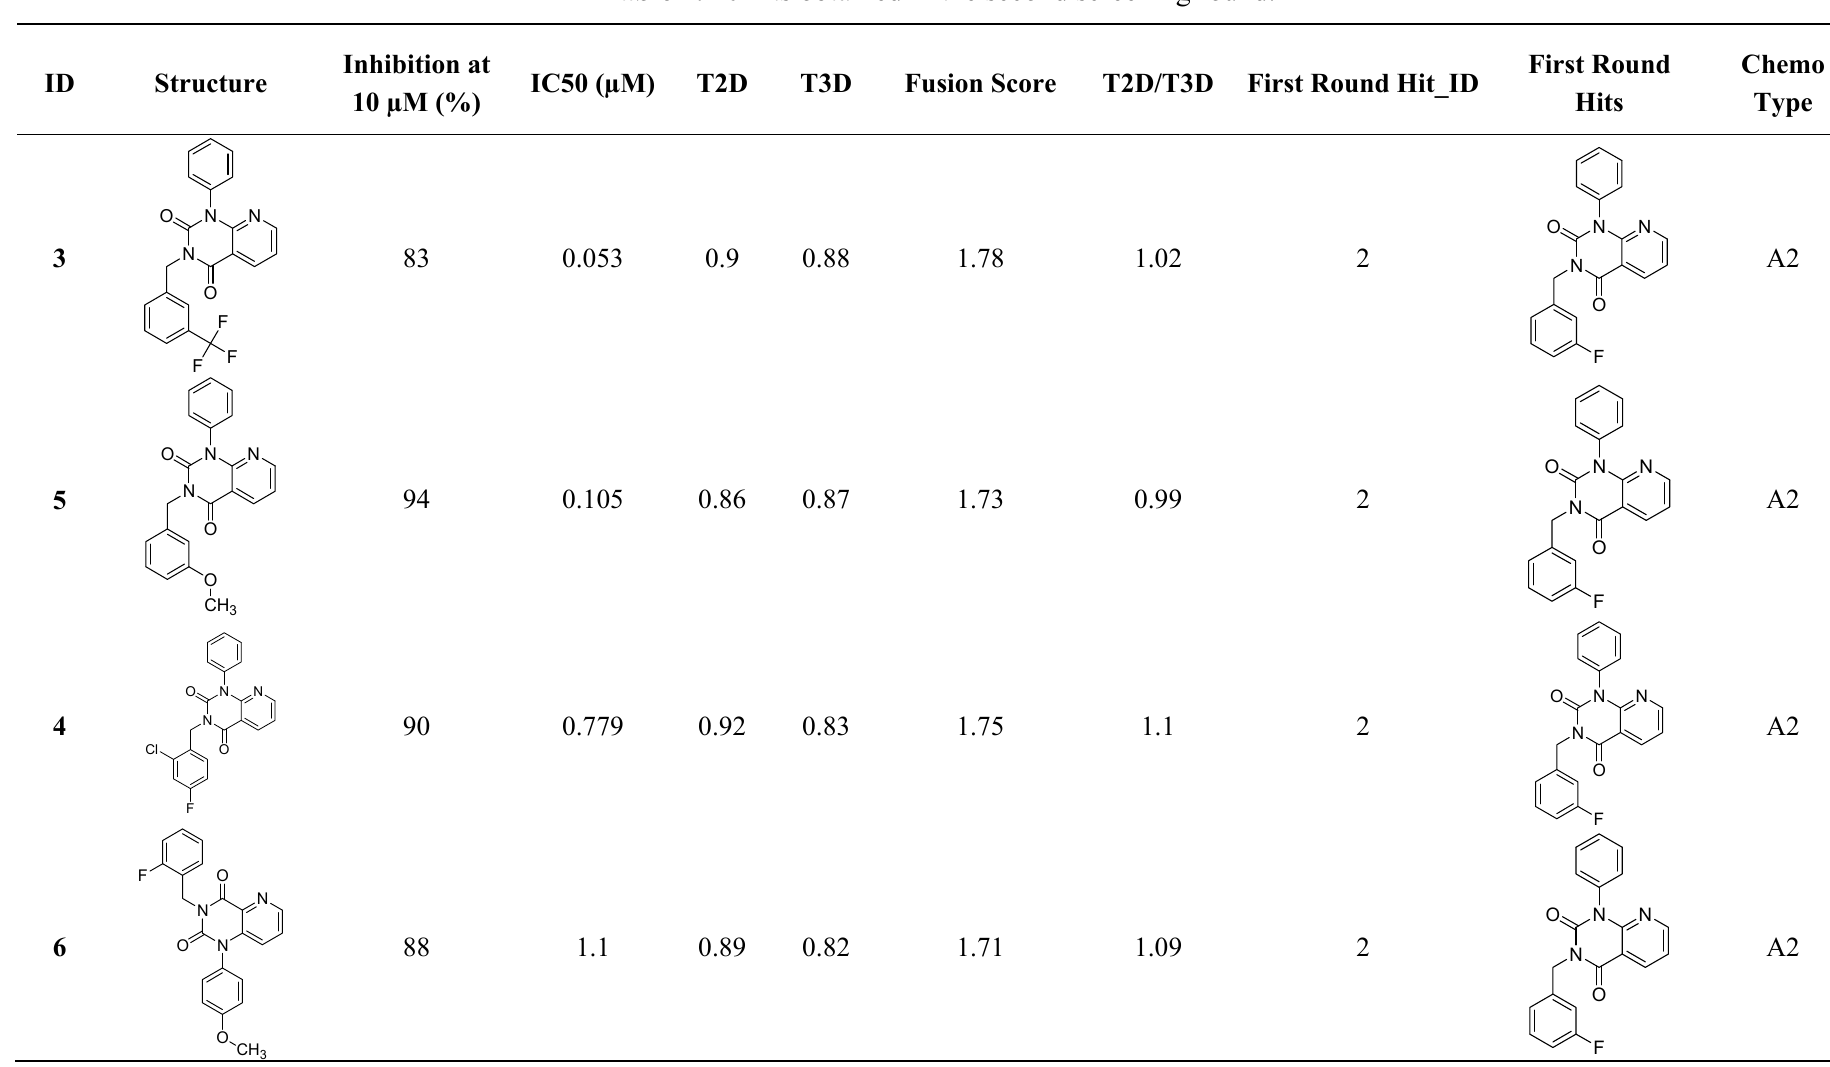
Table 4. 10 hits obtained in the second screening